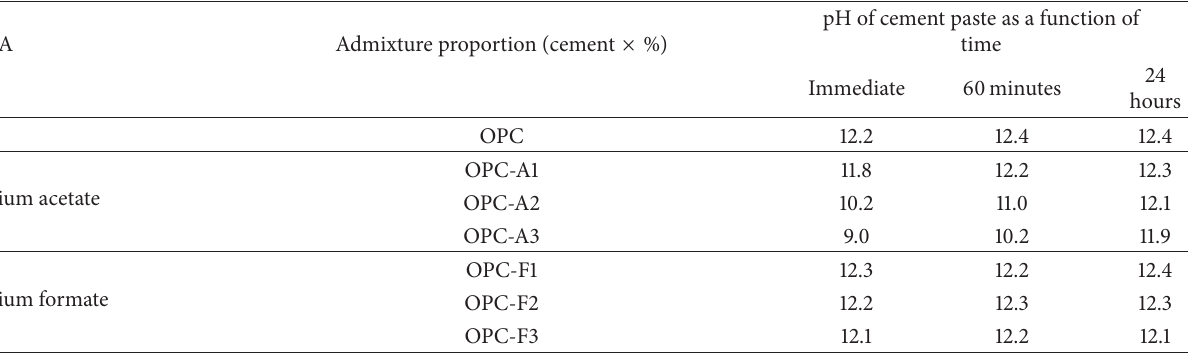
Figure 7: Setting time tests results.